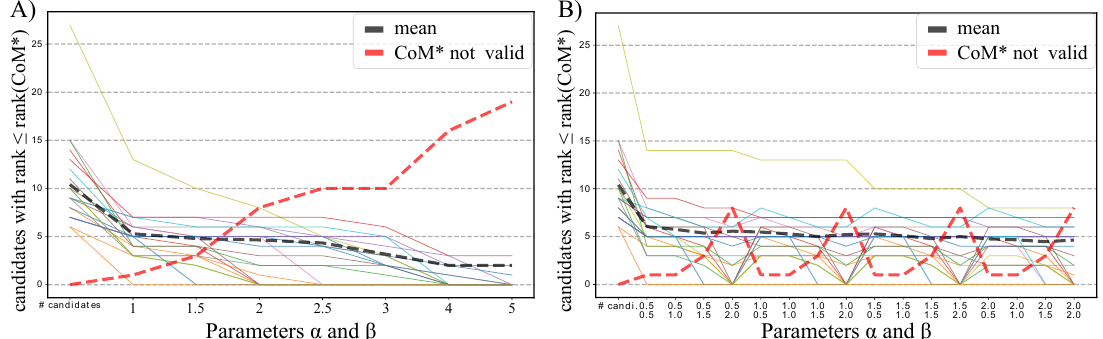
Figure 5. Effect of α / β thresholds on MFE-difference-based CoM classification. Each solid line represents the number of valid CoM candidates for an RNA pair with a rank not higher than the known CoM from literature (designated as CoM*; colors differentiate between the single CoMs). The left-most data points represent the overall numbers of CoM candidates in the RNA pair that harbors the respective CoM*. The black dotted line provides the average over all RNA pairs for α , β > 0. The red dotted line depicts the number of RNA pairs for which the known CoM* does not fulfill the energy constraint. ( A ) Results for equal values of α and β ; ( B ) Results for explicit value combinations of α and β in range [0.5, 2].